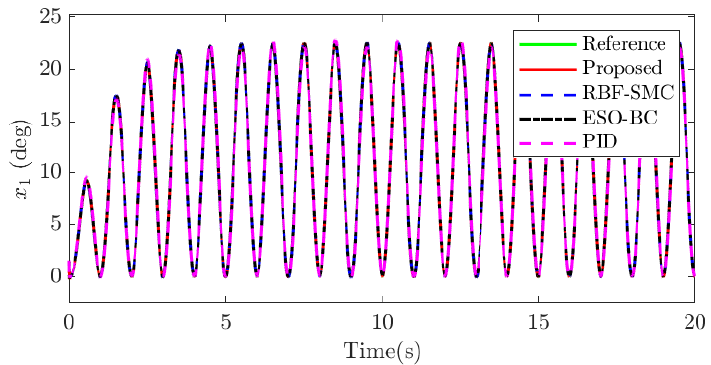
Figure 8. The tracking performance of the proposed strategy compared with other control laws in fast-motion reference trajectory.